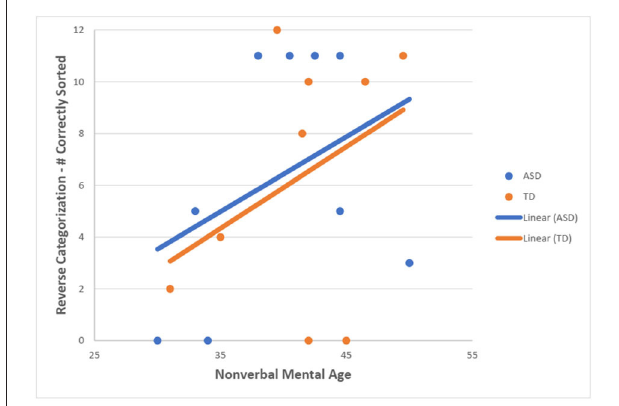
FIGURE 5 | Scatterplot showing the relationship between NVMA and a number of correctly sorted post-switch RC trials for both groups matched on NVMA.